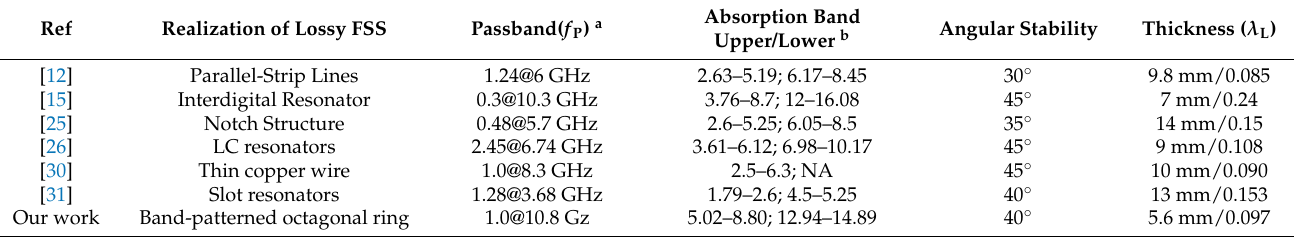
Figure 10. Measured and simulated results of the FSR. ( a , b ) TE polarization at θ = 0° and θ = 40° ( c , d ) TM polarization at θ = 0° and θ = 40°. Table 1. Performance comparison of the previously reported FSR.